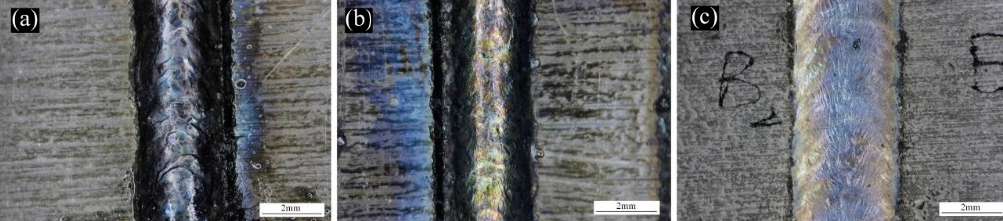
Figure 3. Surface morphology of high entropy alloy laser cladding layer under different specific energies. ( a ) 40.9 J / mm 2 ; ( b ) 58.3 J / mm 2 ; ( c ) 89.3 J / mm 2 .